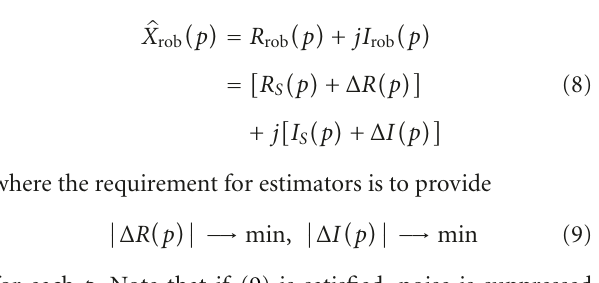
properties, the spectrum estimate obtained by RDFT meth- ods can be represented